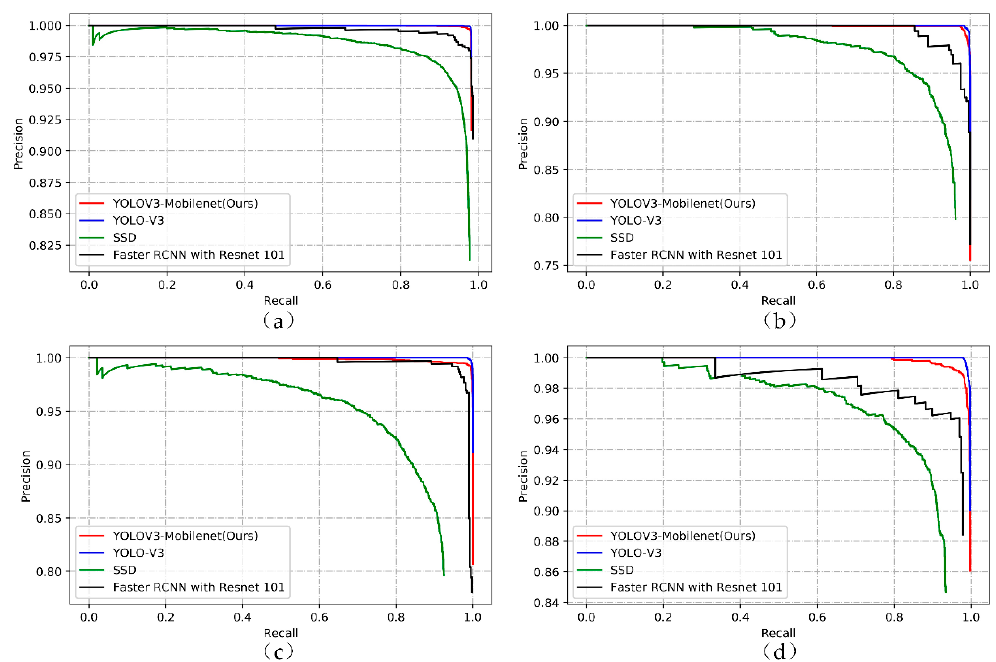
Figure 11. P–R curves of the four electronic components for the detection models: ( a ) capacitor of 470